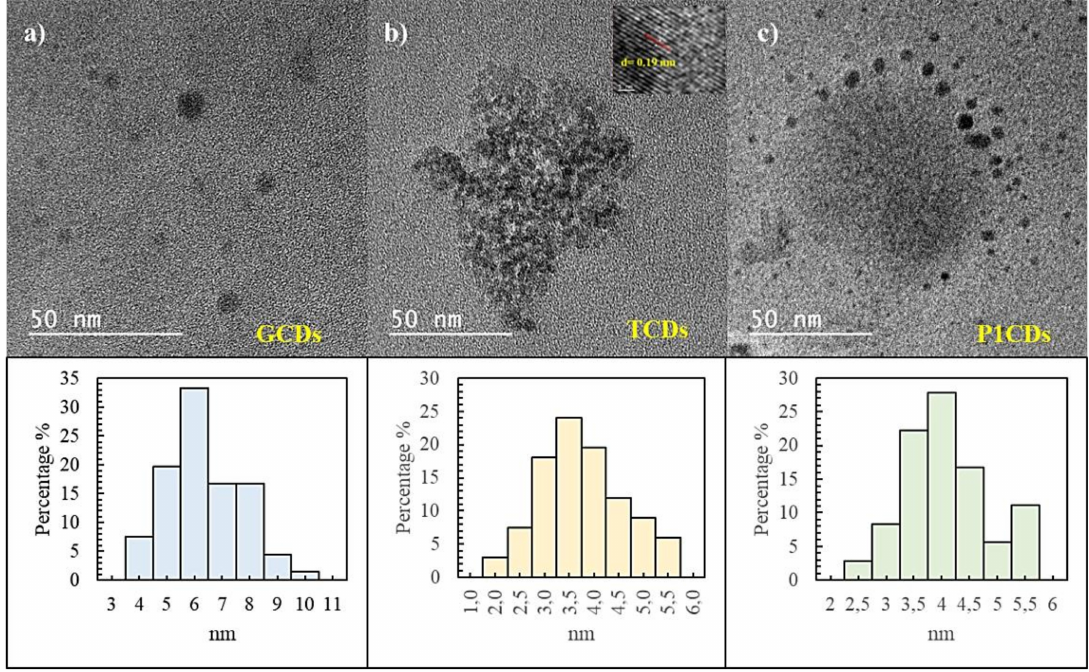
Figure 1. HR-TEM images of ( a ) GCDs, ( b ) TCDs and ( c ) P1CDs samples and their corresponding size distribution histograms; n = 118 TCDs, n = 106 GCDs, n = 144 P1CDs.